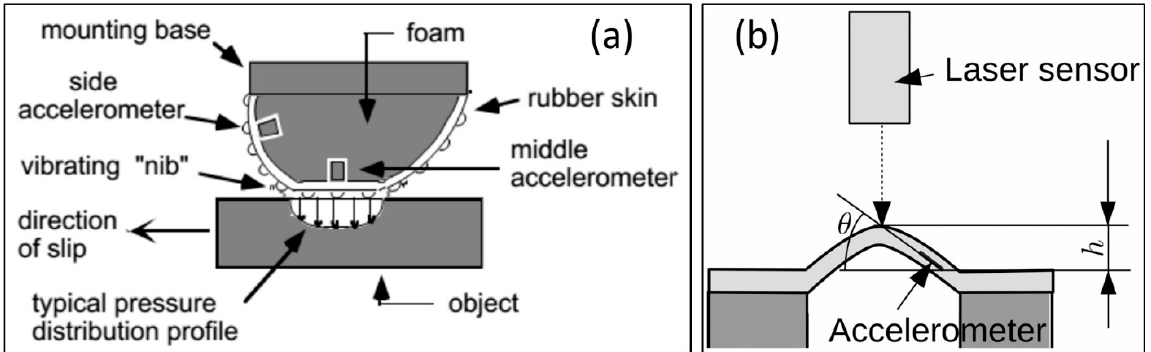
Figure 4. ( a ) Structure of the accelerometer-based artificial fingertip that detects incipient slip. The two accelerometers are used to detect slip-induced vibrations. The foam helps the fingertip conform to the grasped object surface to provide better grip, and reduces grip force control instability problems. The skin is covered with “nibs” that form local contact regions that can slip independently from one another and produce small vibrations. Reprinted/adapted with permission from Ref. [39]. Copyright 2018, IEEE. ( b ) Schematic drawing of experimental setup for measuring height of polymeric skin. Reprinted/adapted with permission from Ref. [40]. Copyright 2019, IEEE.